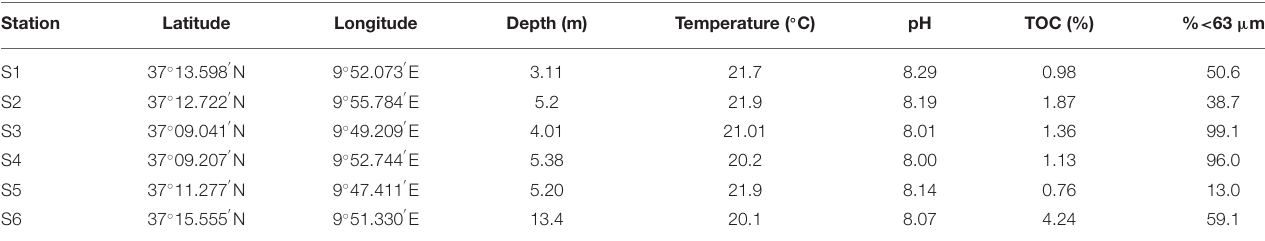
TABLE 1 | Sampling site locations and physico-chemical properties in costal superficial sediments of Bizerte lagoon, Tunisia.